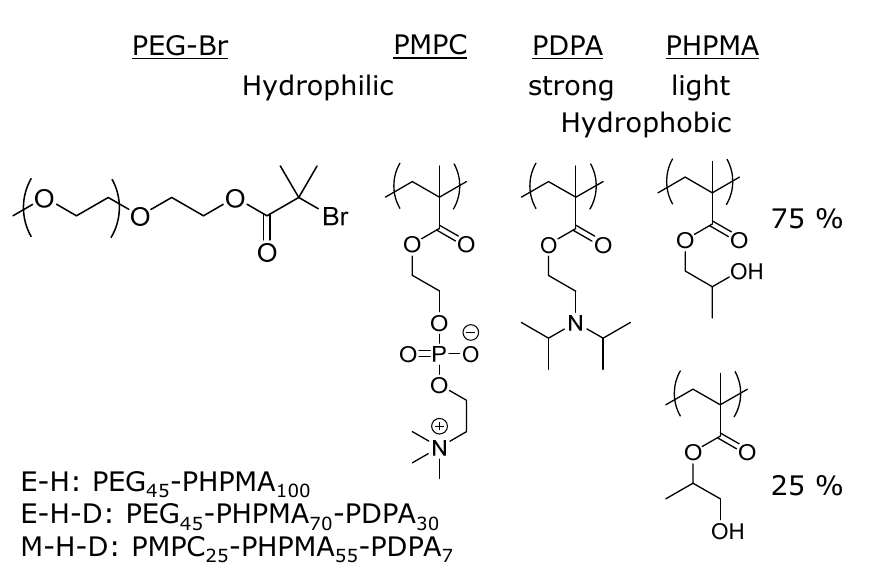
Figure 1. Chemical structures of the polymer blocks used in our studies. PEG and PMPC are hydrophilic blocks, while PHPMA and PDPA are hydrophobic blocks with PDPA being the stronger hydrophobic one.